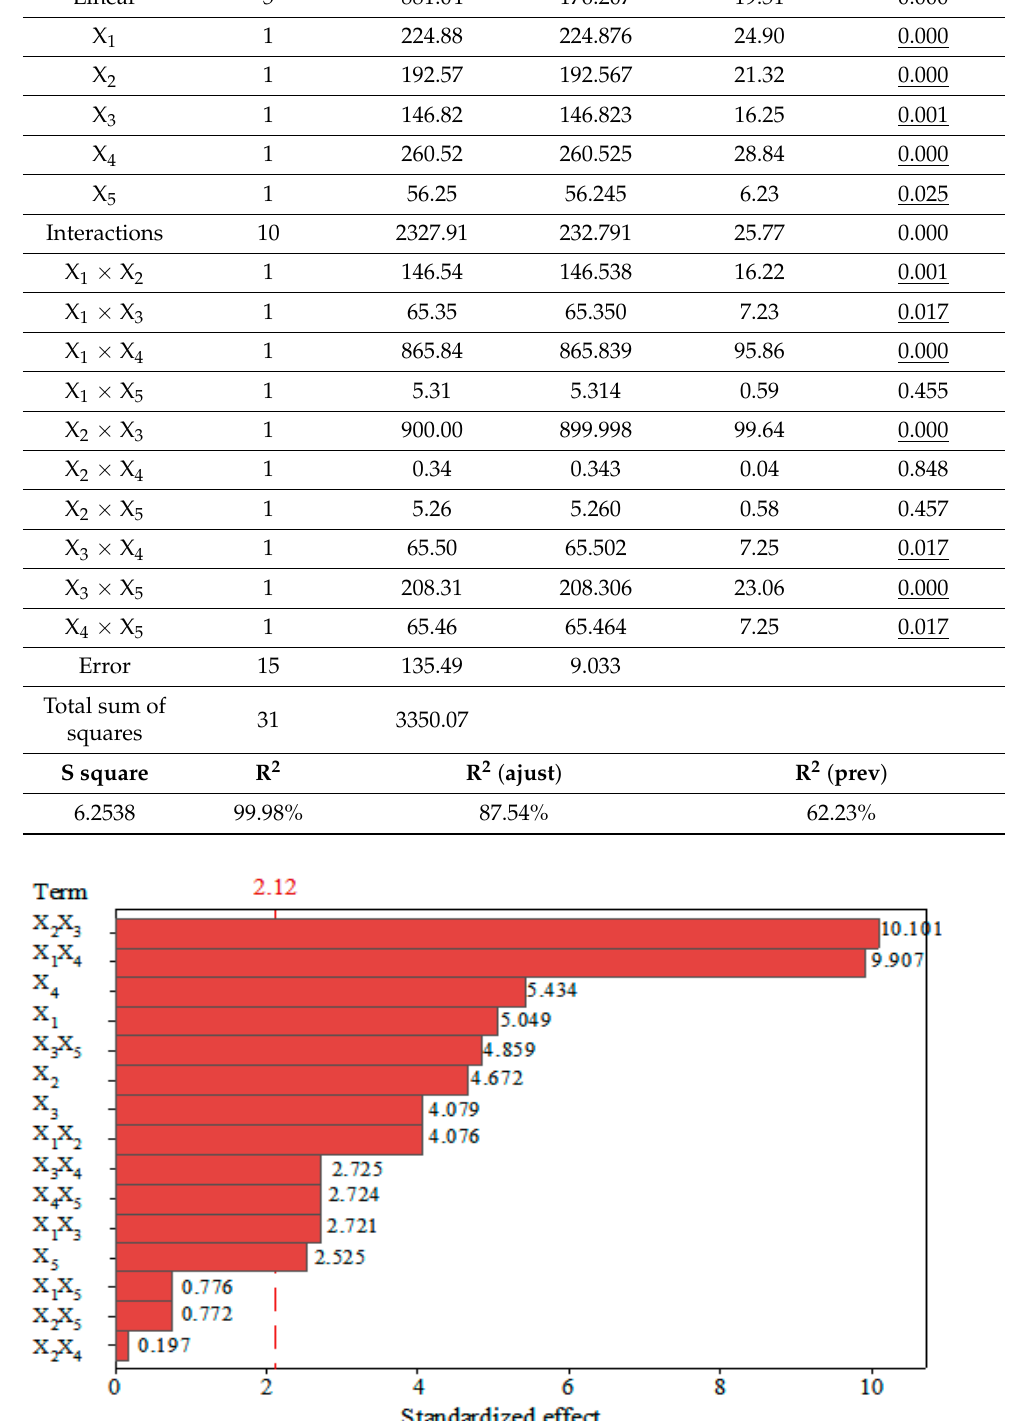
Table 3. Analysis of ANOVA for COD removal. The underline shows the p -values < 0.05. Source DF Adj SS Adj MS F-Value Model